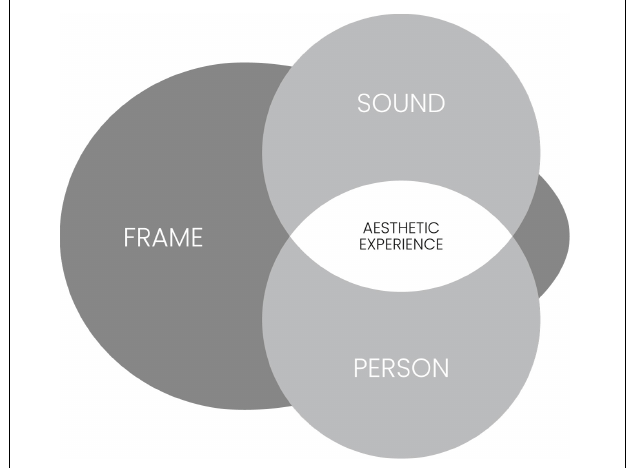
FIGURE 1 | Schematic depiction of a general framework understanding the aesthetic experience of music as the result of the encounter of a person with a sound sequence in a specific frame. Overlaps of Frame and Sound and Frame and Person indicate mediating effects, overlaps of all three components indicate moderating effects of the